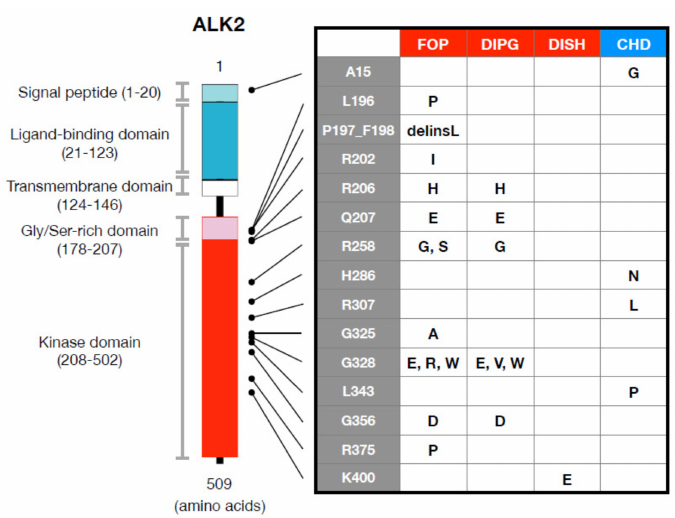
Figure 3. Basic structure of ALK2/ACVR1 and mutations reported in genetic disorders. Human ALK2 consists of 509 amino acids: 1–20, signal peptides; 21–123, ligand-binding domain in the extracellular space; 124–146, transmembrane domain; 178–207, glycine (Gly) and serine (Ser)-rich domain, which is a regulatory switch of the kinase; 208–502, a serine and threonine kinase domain, which phosphorylates downstream substrates in cytoplasm. Amino acids with positions in wild- type ALK2/ACVR1 (the first row from left in a table) are substituted in fibro-dysplasia ossificans progressiva (FOP), diffuse intrinsic pontine glioma (DIPG), diffuse idiopathic skeletal hyperostosis (DISH), and primary focal hyperhidrosis (PFH). Please note that several substitutions overlap in FOP and DIPG. Capital letters in the table are amino acid residues mutated in the